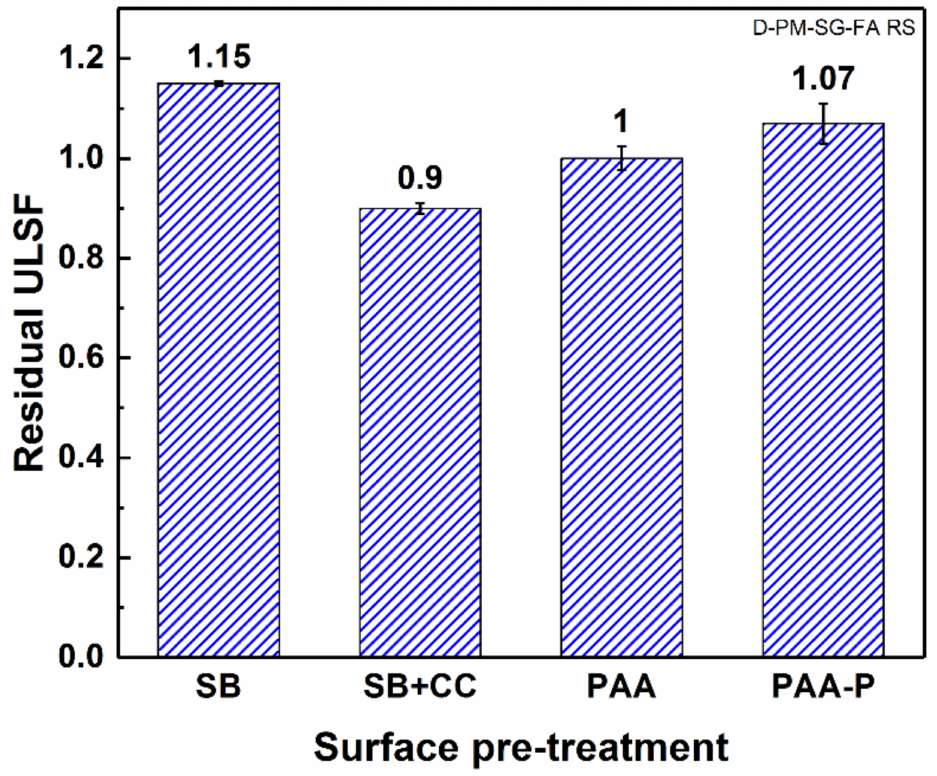
Figure 5. Residual strength of the joints for the surface pre-treatments after 10 6 cycles of fatigue